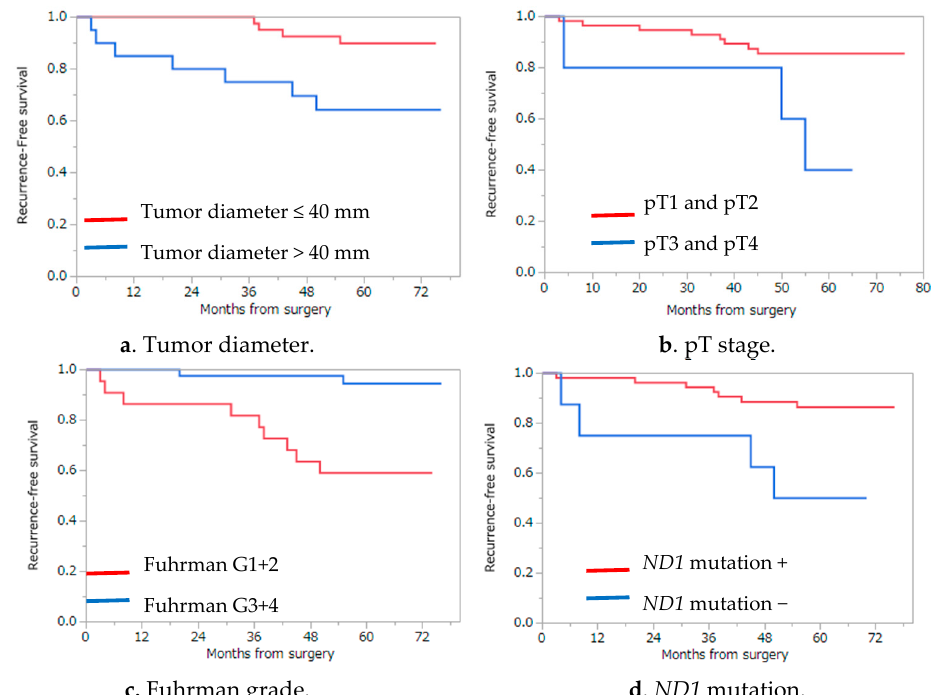
Figure 3. Results of Kaplan–Meier analysis for RFS, which showed statistically significant differences by the log-rank test. ( a ) tumor diameter ( p = 0.0091); ( b ) pT stage ( p = 0.0122); ( c ) Fuhrman grade ( p = 0.0070); and ( d ) ND1 mutation ( p = 0.0006) were candidates as postoperative prognostic factors for localized renal cell carcinoma.